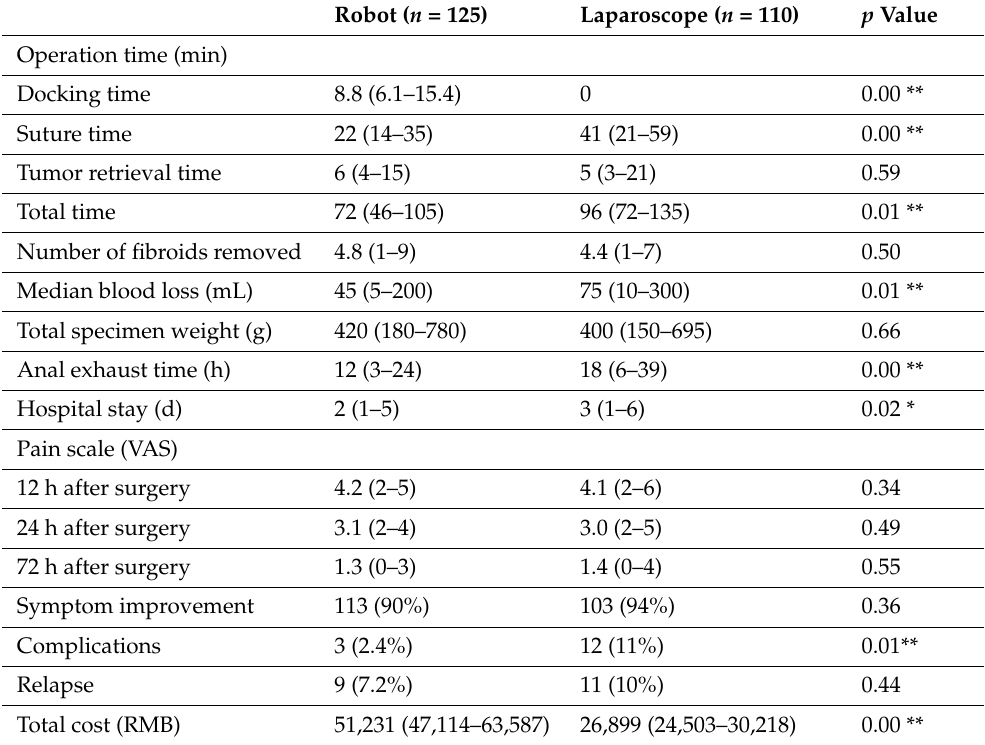
Table 2. Intraoperative and postoperative